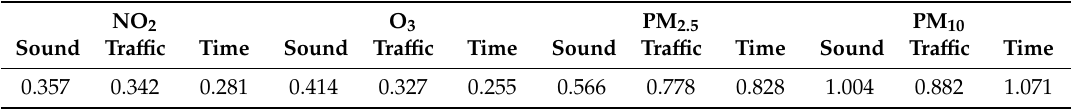
Table 6. Model Quality Index (MQI) of NO 2 , O 3 , PM 2.5 and PM 10 developed by Forum for Air Quality Modelling in Europe (FAIRMODE). Values greater than 1 represent a model performance that is not su ffi ciently